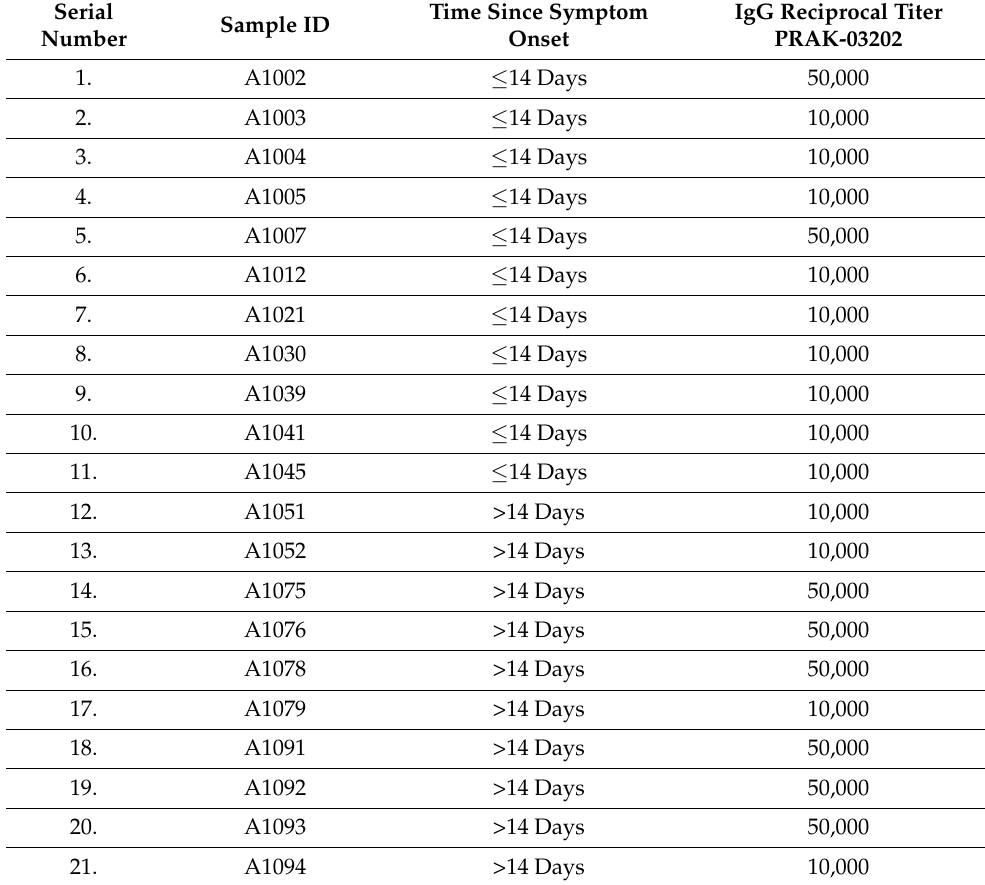
Table 4. End-point dilution titers of IgG antibodies to PRAK-03202 in a subset of early and later phase